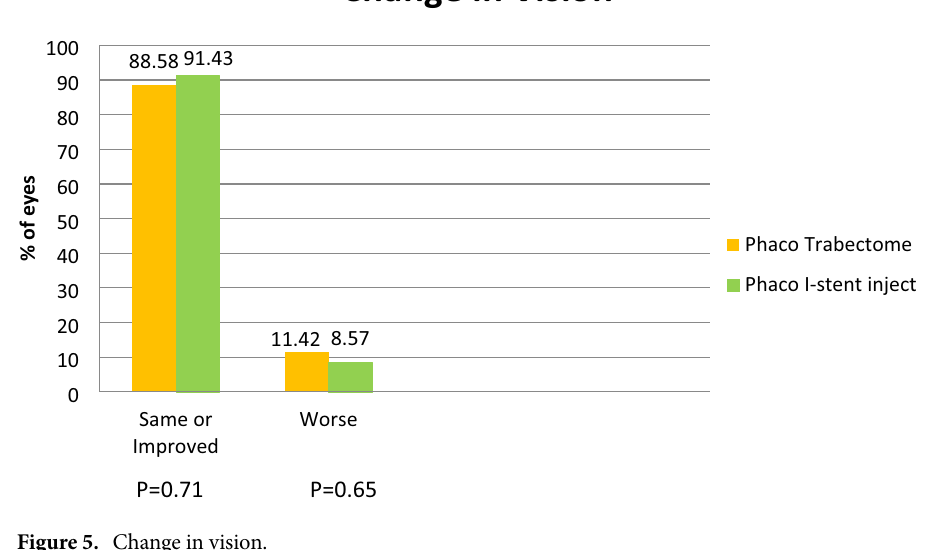
Figure 5. Change in